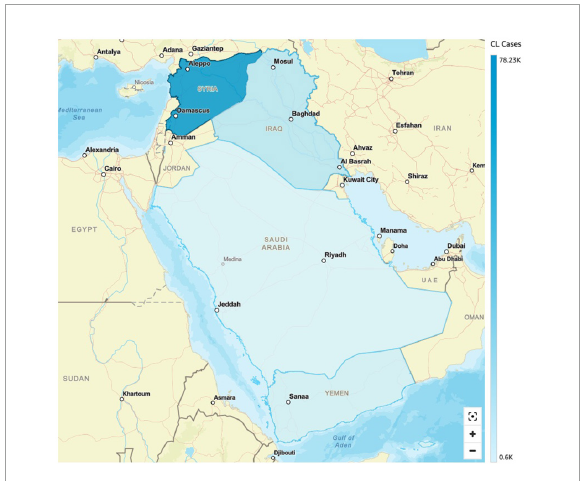
FIGURE4 Incidence of cutaneous leishmaniasis (CL) in selected Middle Eastern countries (Saudi Arabia, Iraq, Syria and